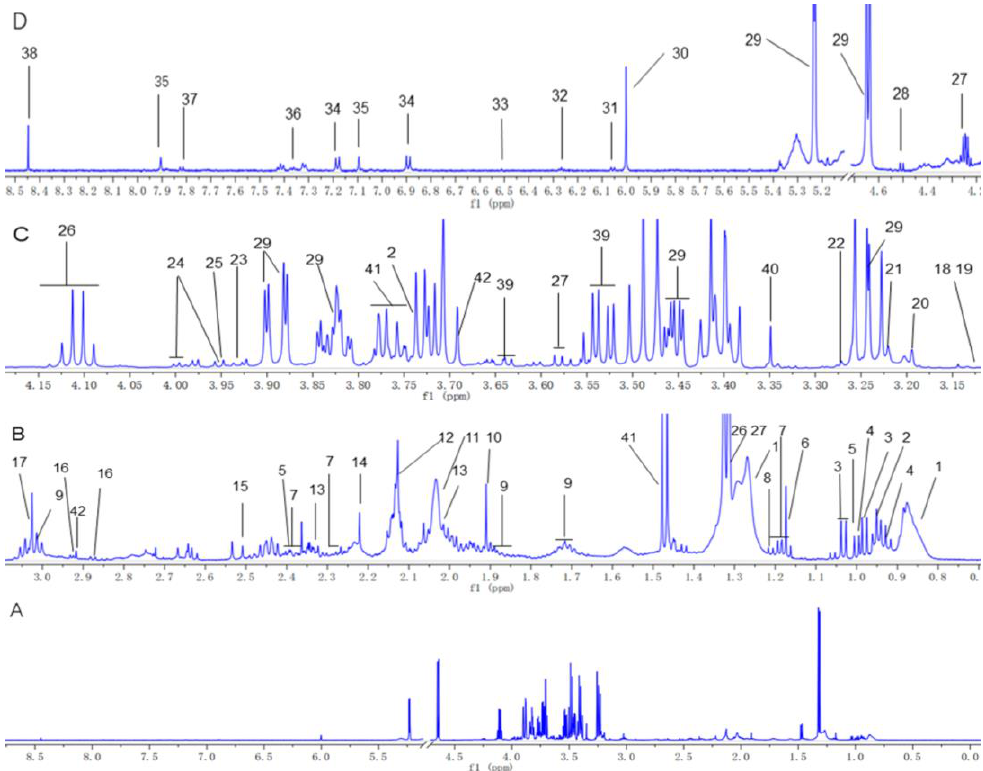
Figure 4. 1H-NMR spectra of rat plasma sample. ( A ) Full 1H-NMR spectrum from δ 0.0 to 9.0. ( B ) Enlarged spectrum from δ 0.7 to 3.1. ( C ) Enlarged spectrum from δ 3.1 to 4.17. ( D ) Enlarged spectrum